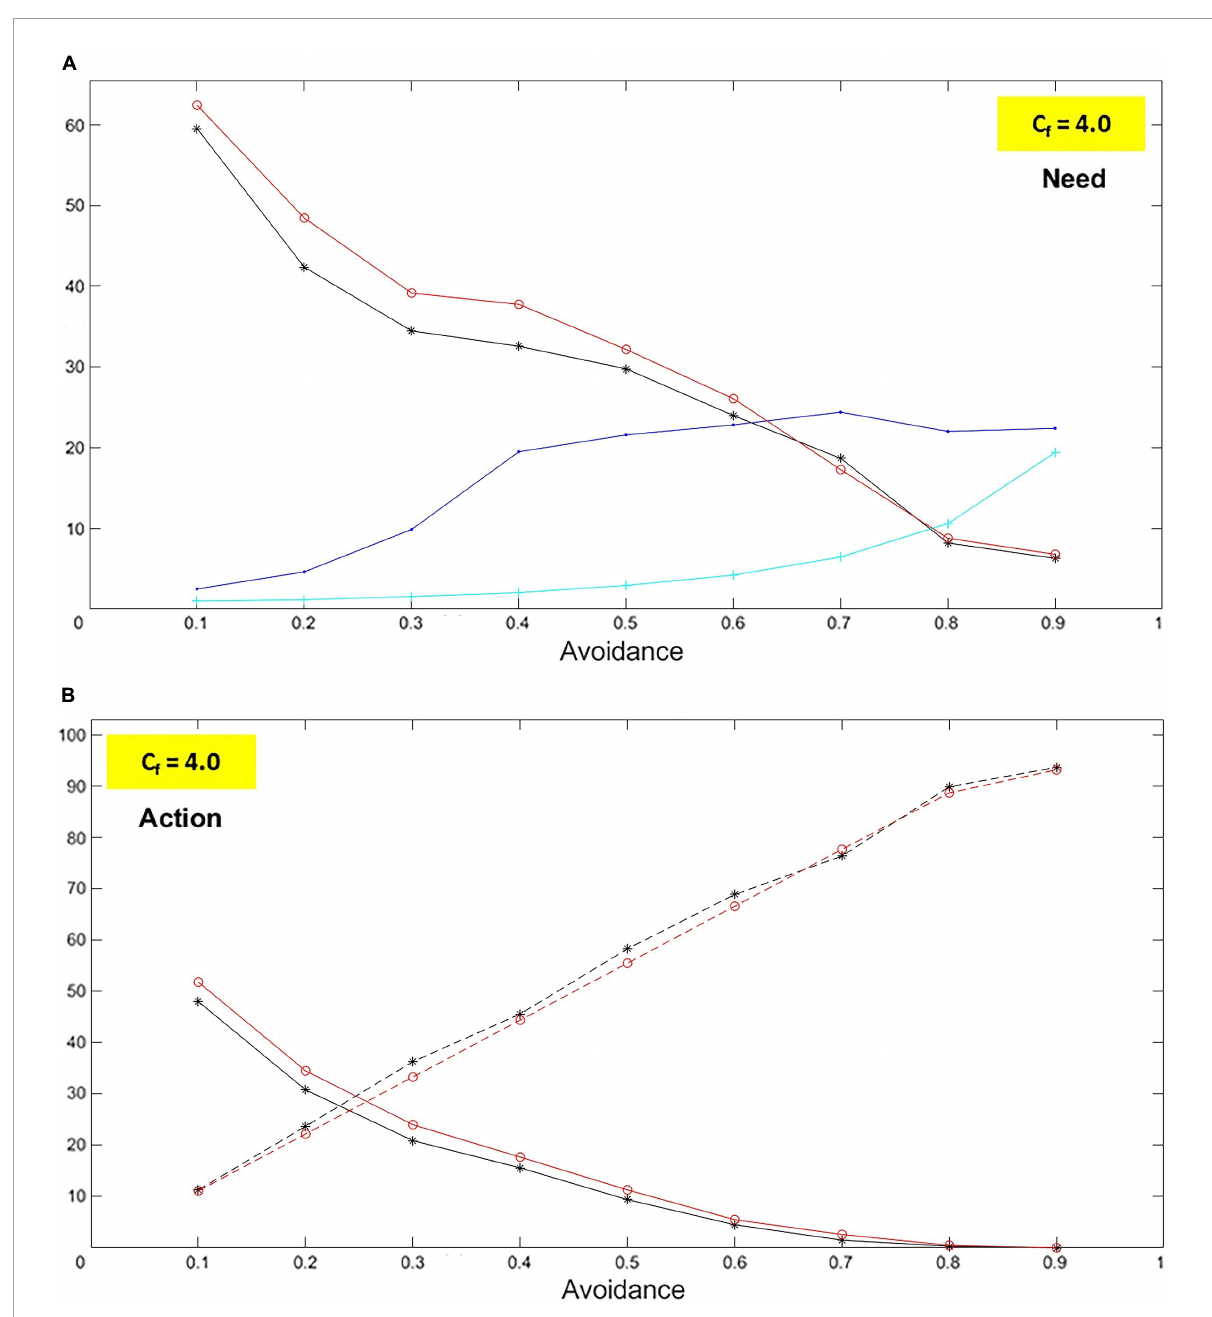
FIGURE11 Avoidant case: Need and action. The graphs represent characteristics for the child (black curves) and the caregiver (red curves) for levels of avoidance ( A v ) and insensitivity ( I n ) ranging between 0.1 and 0.9 (with step 0.1). The blue curve represents the distance measured in the lab between the child and the caregiver. The cyan curve represents the number of iterations without caregiving. In particular, as A v and I n increase, it is shown that: (A) The needs to receive care (felt by the child) and give care (felt by the caregiver) decrease. (B) The child and the caregiver both increase their exploration (dashed curves) while they decrease their approaches. All these phenomena are entirely consistent with what attachment studies